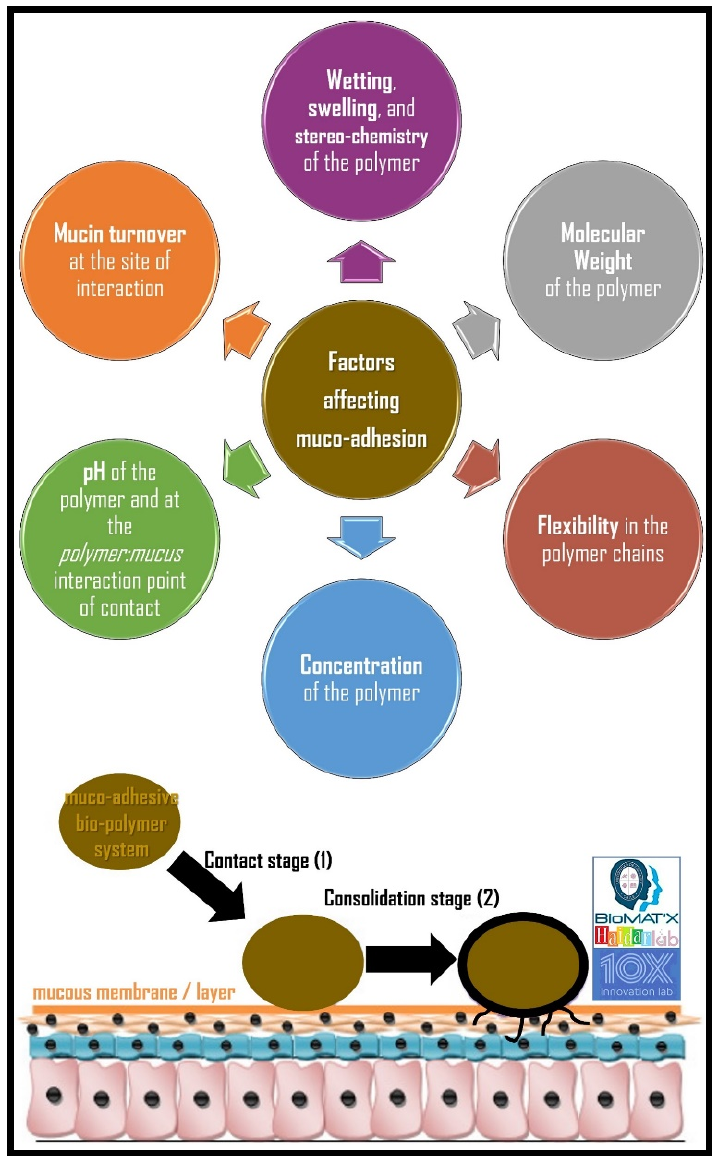
Figure 2. Two-stage mechanism and factors involved in muco-adhesion and drug delivery.